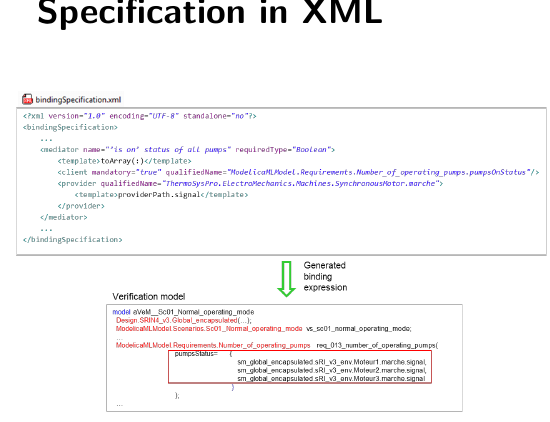
Figure 8: Bindings specification is used to generate binding